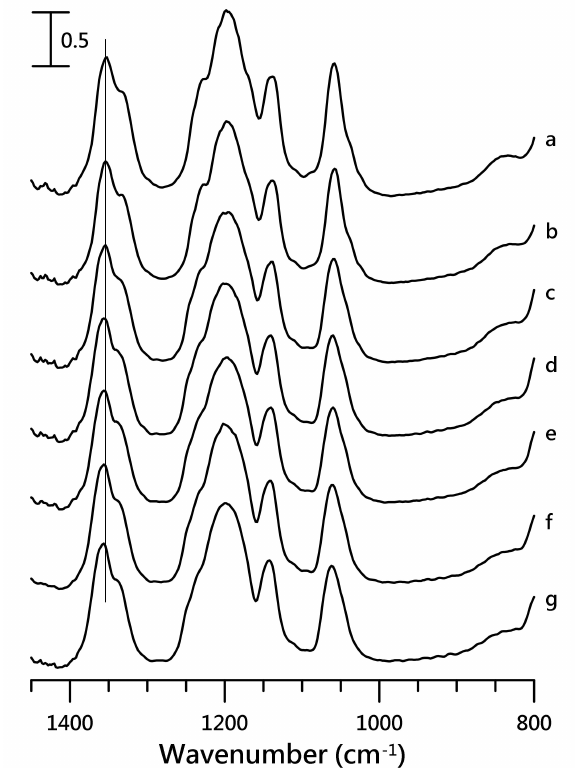
Figure 5. IR spectra of pure [HMIM][NTf 2 ] obtained at ( a ) ambient pressure and ( b ) 0.4, ( c ) 0.7, ( d ) 1.1, ( e ) 1.5, ( f ) 1.8, and ( g ) 2.5